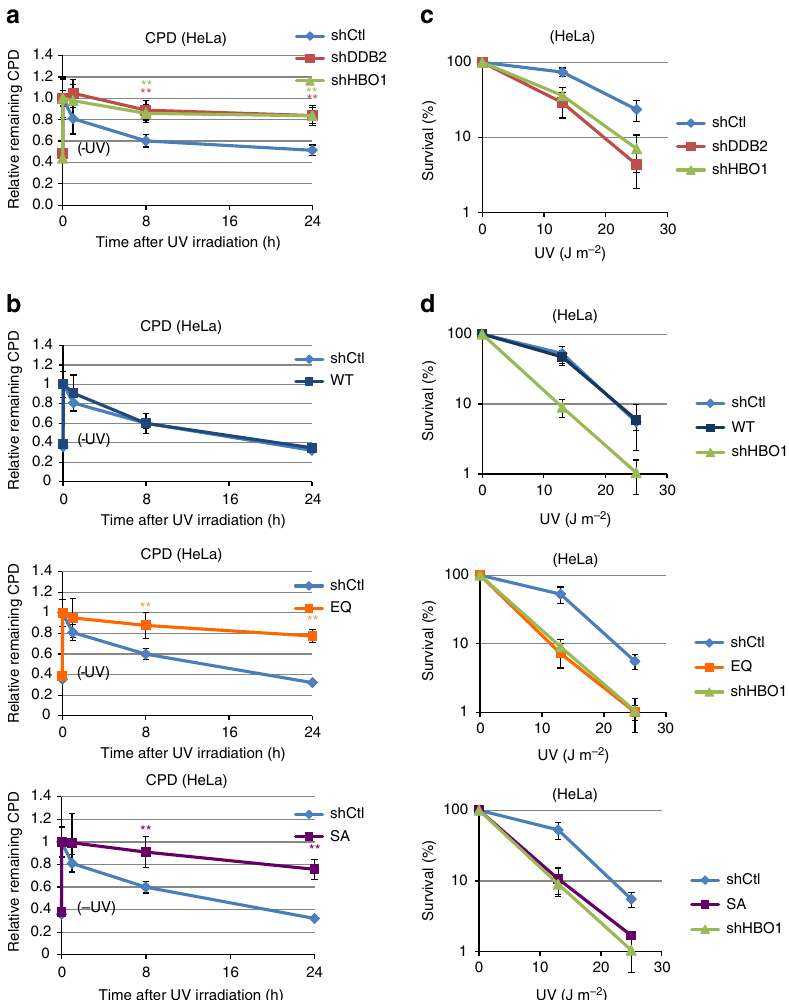
Figure 5 | Depletion of HBO1 or mutant HBO1 causes defective CPD repair and increases sensitivity to ultraviolet irradiation. ( a , b ) ShCtl, shDDB2 and shHBO1 ( a ) or shHBO1 Myc-HBO1 WT, EQ or SA-expressing cells ( b ) were not irradiated (-ultraviolet) or irradiated with 12Jm (cid:2) 2 ultraviolet, and then cultured for 0, 1, 8 and 24h. Cells were then fixed and immunostained with anti-CPD antibody and DNA was counterstained with DAPI. Relative intensities of CPD normalized against DAPI are shown as fold of ultraviolet 0h cells. Cells ( n ¼ 50) from three independent experiments; error bars indicate means ± s.d. ** P o 0.01 (Student’s t -test). ( c , d ) ShCtl, shDDB2 and shHBO1 ( c ) or shHBO1 and shHBO1 Myc-HBO1 WT, EQ or SA-expressing cells ( d ) were irradiated at the indicated ultraviolet dose. Cells were cultured for 2 weeks and then fixed with MeOH/acetic acid and stained with crystal violet solution. The numbers of colonies were counted and are represented as % of mock-irradiated cells. Three independent experiments were performed. Error bars indicate means ±